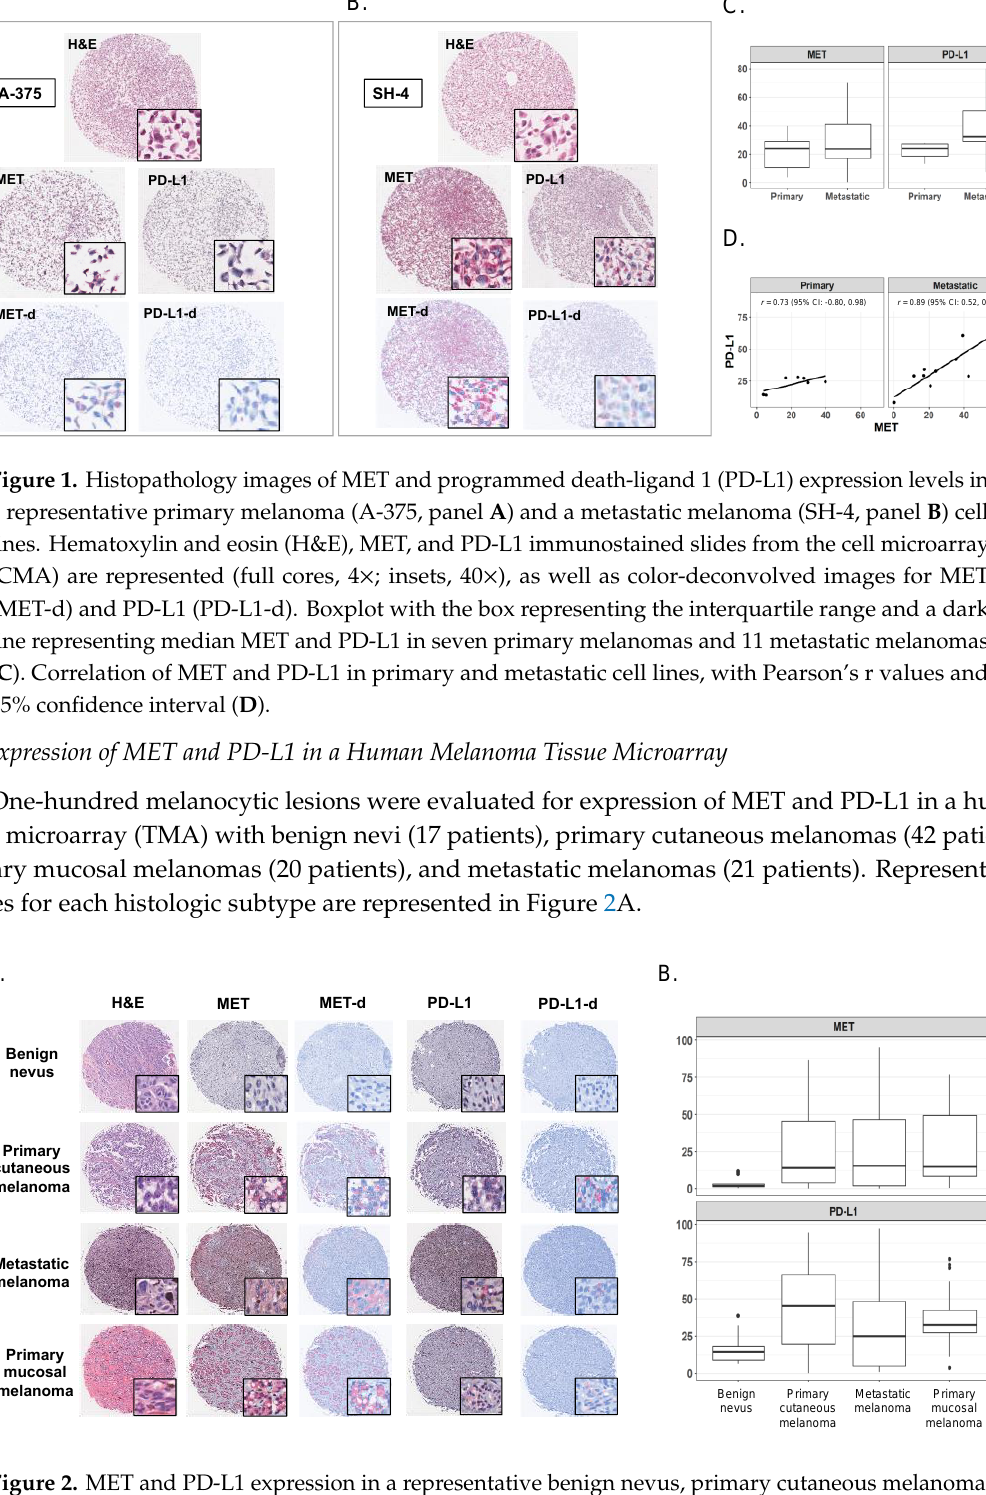
Figure 2. MET and PD-L1 expression in a representative benign nevus, primary cutaneous melanoma, metastatic melanoma, and primary mucosal melanoma. Hematoxylin and eosin (H&E), MET, and PD-L1 immunostained slides from the tissue microarray (TMA) are represented (full cores, 4×; insets, 40×), as well as color-deconvolved images for MET (MET-d) and PD-L1 (PD-L1-d) (panel A ). Boxplot with the box representing the interquartile range and a dark line representing median MET and PD-L1 in benign nevi, primary cutaneous melanoma, metastatic melanoma, and primary mucosal melanoma (panel B